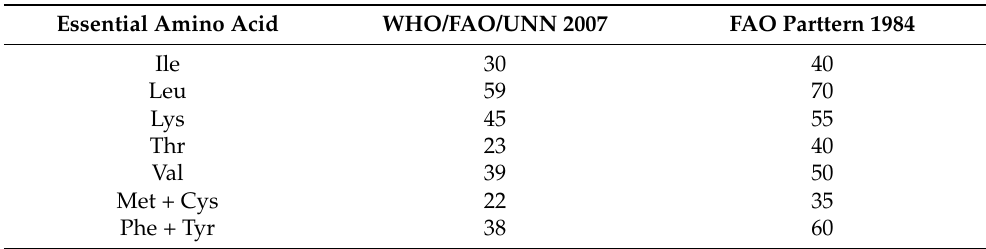
Table 1. Essential amino acid content in “ideal” protein in amino acid scoring patterns in the 2007 FAO/WHO/UNU and FAO pattern reports. Essential Amino Acid WHO/FAO/UNN